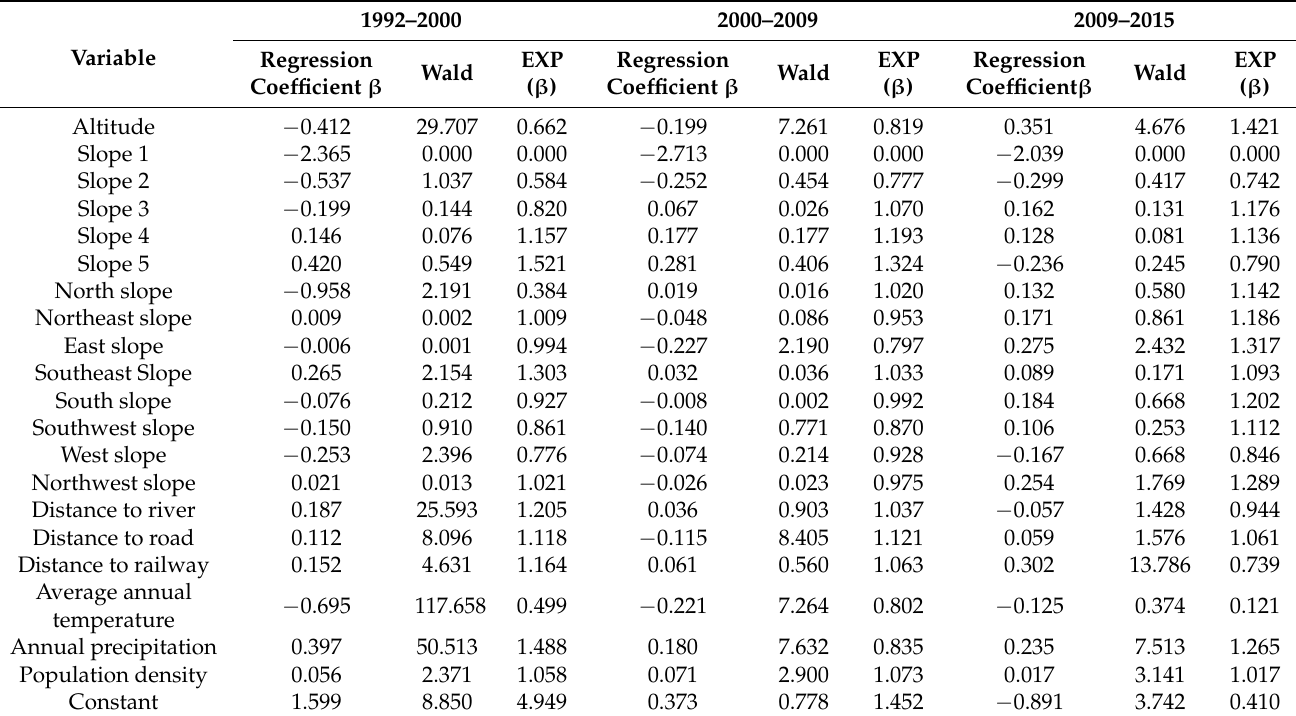
Table A1. Model estimates for cultivated land expansion driving